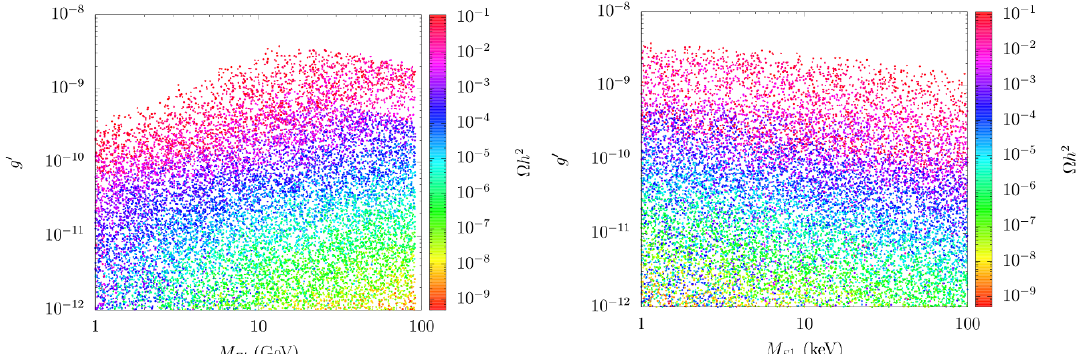
Figure 8 . Allowed points in ( M Z 0 ; g 0 ) and ( M ; g 0 ) planes after imposing an upper bound on the S 1 1 WDM relic density (cid:10) h 2 (cid:20) 0 : 12. The color bars of left and right panels correspond to (cid:10) h 2